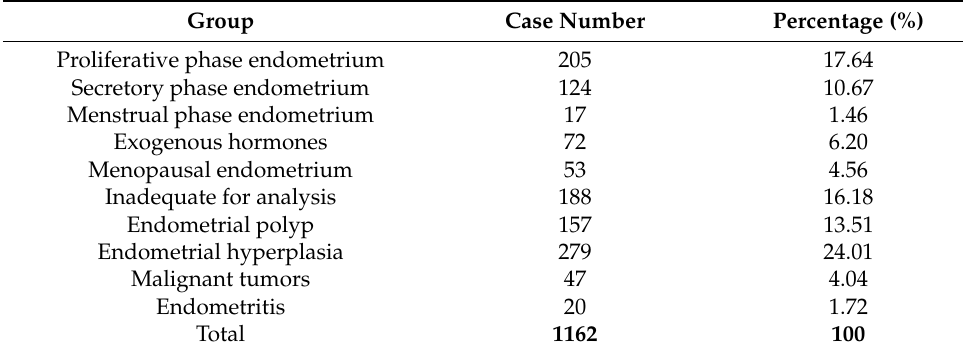
Table 4. Histopathological findings of 1162